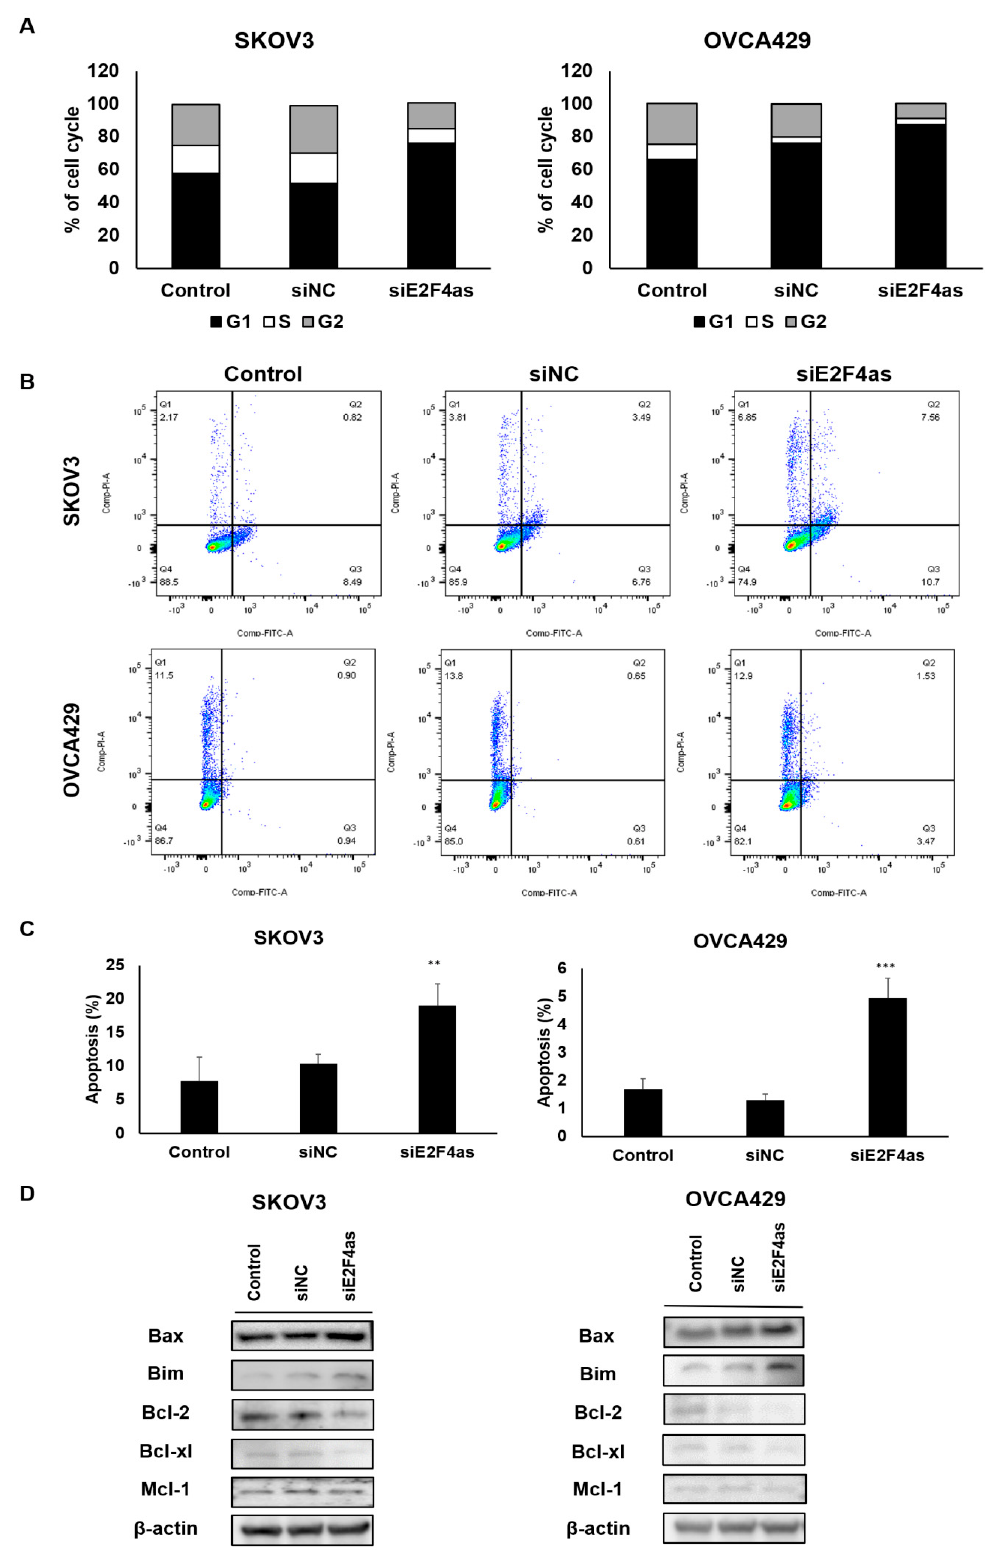
Figure 4. Inhibition of E2F4as promote apoptosis of ovarian cancer cells. ( A ) Cell cycle was arrested in the G1 phase after transfection of siE2F4as in ovarian cancer cells. ( B ) Ovarian cancer cells were transfected with siNC, siE2F4as, and control in triplicate for 48 h to detect cell apoptosis using FITC Annexin V apoptosis kit. ( C ) Levels of apoptosis in siE2F4as analysed using FACS Canto